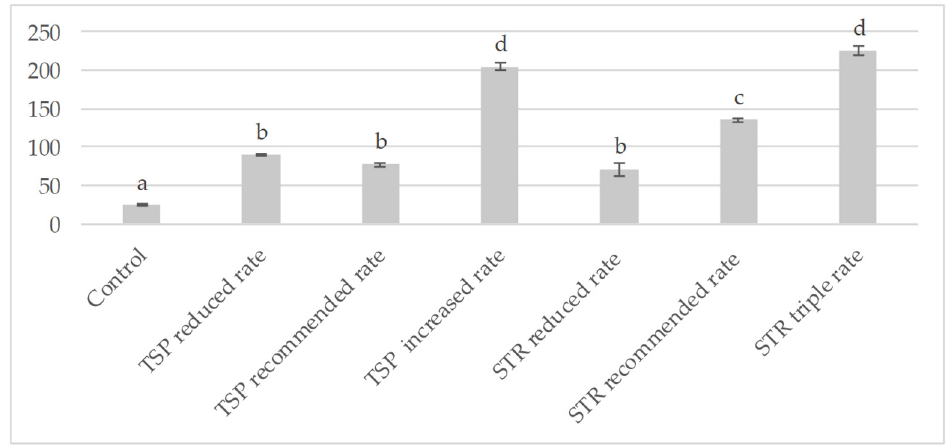
Figure 8. Phosphorus content in the peat (mg dm − 3 ) as affected by the interaction of examined factors (A × B) at the level of significance α = 0.05 ( p value < 0.01).